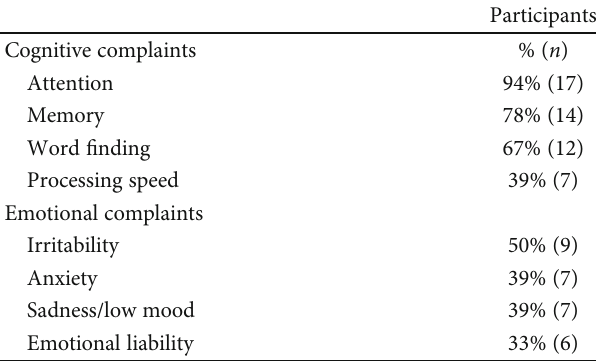
Table 3: Subjective cognitive and emotional